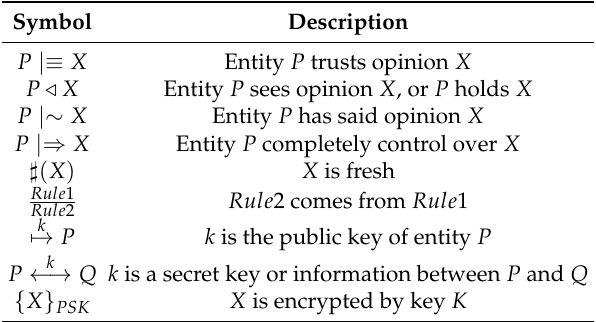
Table 2. Symbol and description of BAN